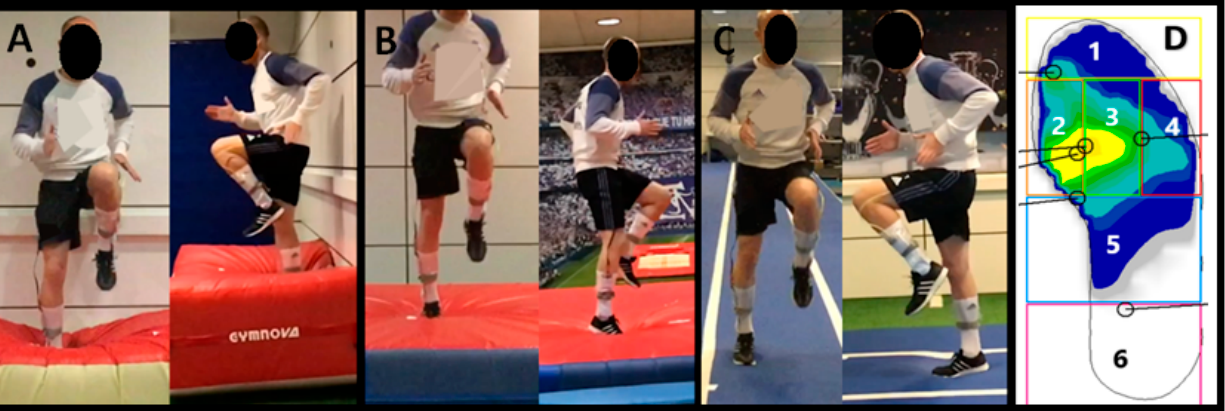
Figure 1. Procedure to run on three mats with different hardness: soft ( A ), hard ( B ) and air chamber ( C ). Layout of pressure measurement zones ( D ) for the toes (1), the first metatarsal (2), the second, third and fourth metatarsals (3), the head of the fifth metatarsal (4), the longitudinal arch of the foot (5) and the calcaneus (6).